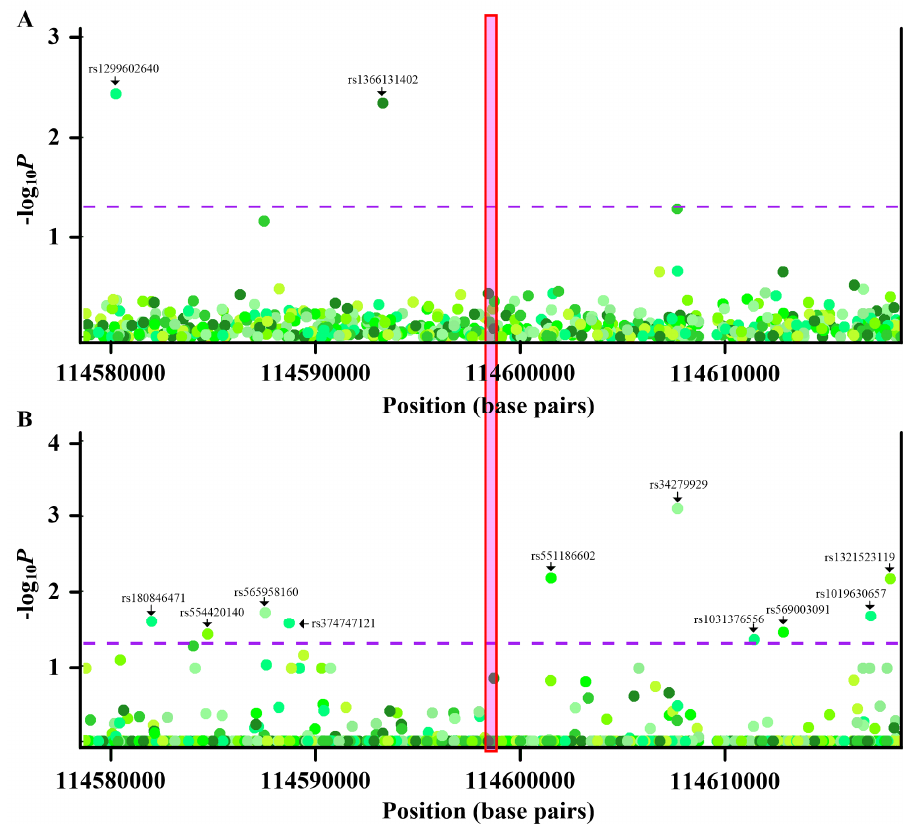
Figure 3. Genetic and methyl-quantitative trait locus (meQTL) analysis of cg26201826 ( PGGT1B ). ( A ) Regional association plots of nearby variants with methylation levels of cg26201826. X-axis represents positions on the respective chromosome. Y-axis represents negative log 10 P of associations between variants and cg26201826 methylation. The variants with p values less than the threshold are labeled with corresponding rs numbers. The associations between variants and CpG methylation are calculated with multiple regression, correcting for sex, age, smoking history (total pack-years), smoking status, alcohol consumption, and blood cell subsets. ( B ) Regional association plots of nearby variants with gout. X-axis represents positions on the respective chromosome. Y-axis represents negative log 10 P of associations between variants and gout. The variants with p values less than threshold are labeled with corresponding rs numbers. Every point is one variant colored with a respective hue, with different colors implying different variants. The dashed purple lines indicate the significance threshold ( p = 0.05), and the red box highlights the location of cg26201826. The associations between variants and gout are calculated with multiple regression, correcting for sex, age, smoking history (total pack-years), smoking status, alcohol consumption, and blood cell subsets.